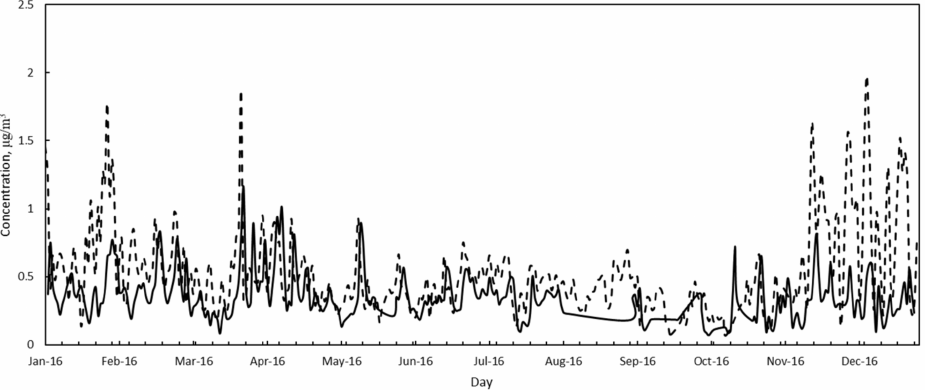
Figure 6. Cadmium daily average concentrations measured in the HI (dashed black line) and LI (solid black line) area during 2016 from the ARPAC network.